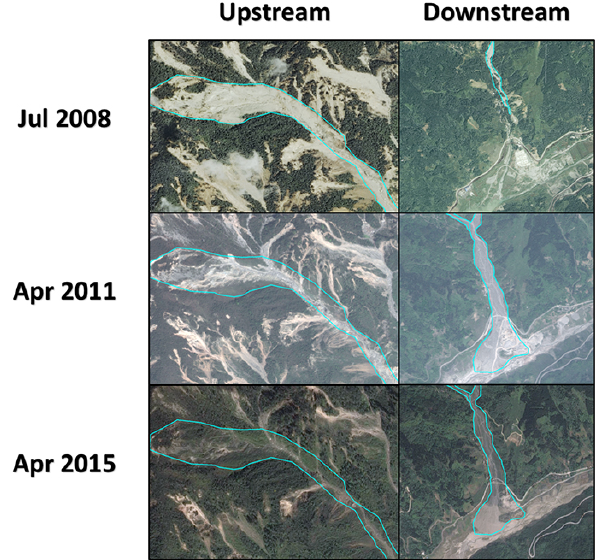
Figure 12. Examples of changes in landslide activity in the source and deposition areas of a typical debris flow gulley. In 2008 the loose materials produced by this co-seismic landslide were still lo- cated in the upslope part of the valley. After three rainy seasons, de- bris flows and erosion transported the materials to the downstream area. In 2015, most of the upstream area was covered by vegetation again, and debris flow activity in the downstream part had reduced